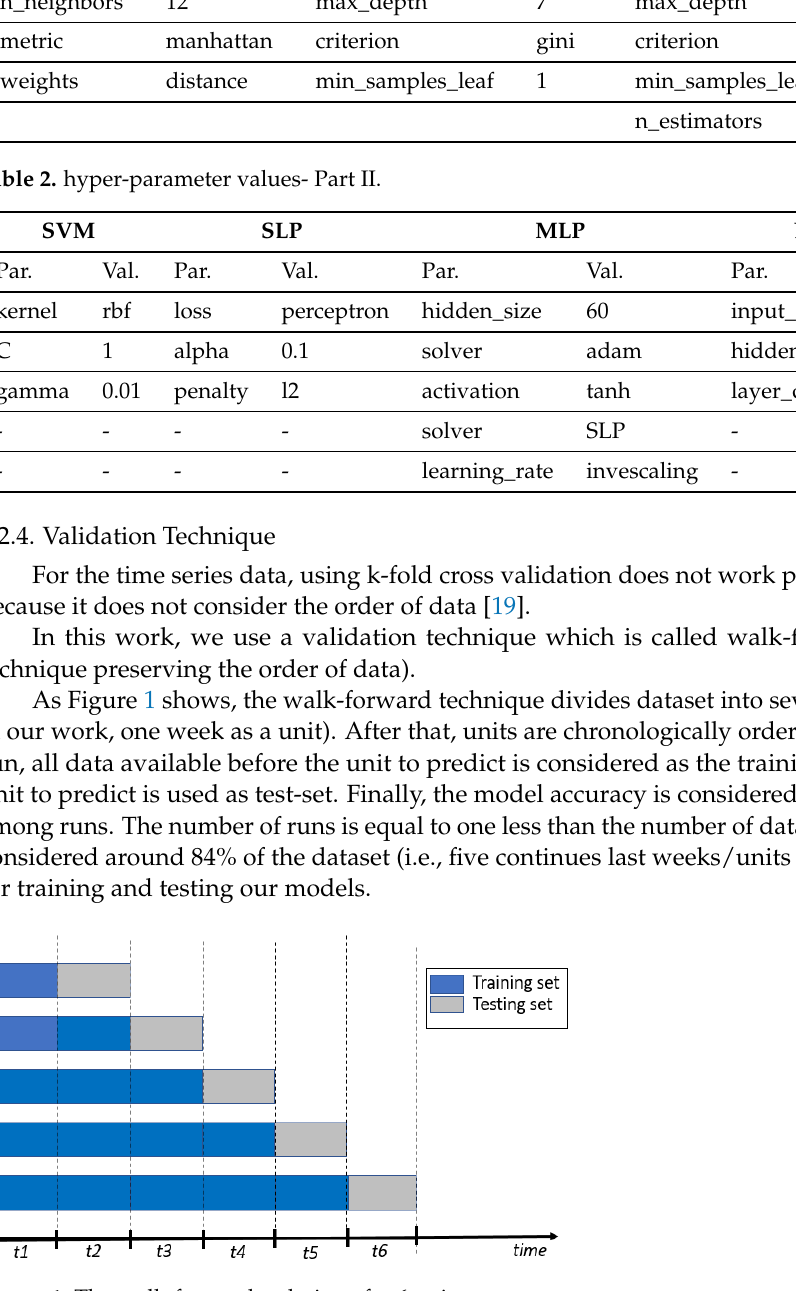
metric manhattan criterion gini criterion entropy weights distance